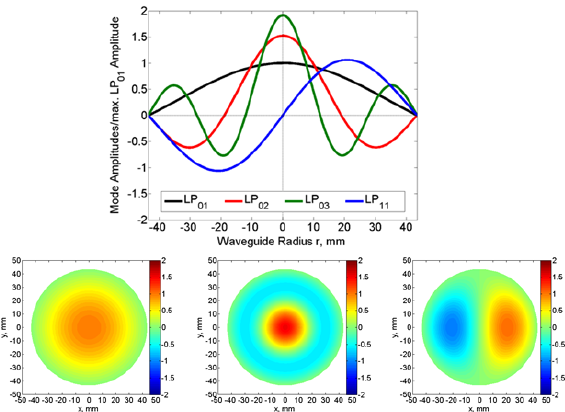
Figure 2. Mode amplitudes in the OCCWG cross section at y = 0 (top) and 2D amplitude distribution of main transmission mode LP 01 (bottom left) and marker modes for LP 02 (bottom mid, beam waist mismatch) and LP o (bottom right, o ff set / tilt). 11 Even first mode indices (m) relate to symmetric, odd first indices to asymmetric modes.